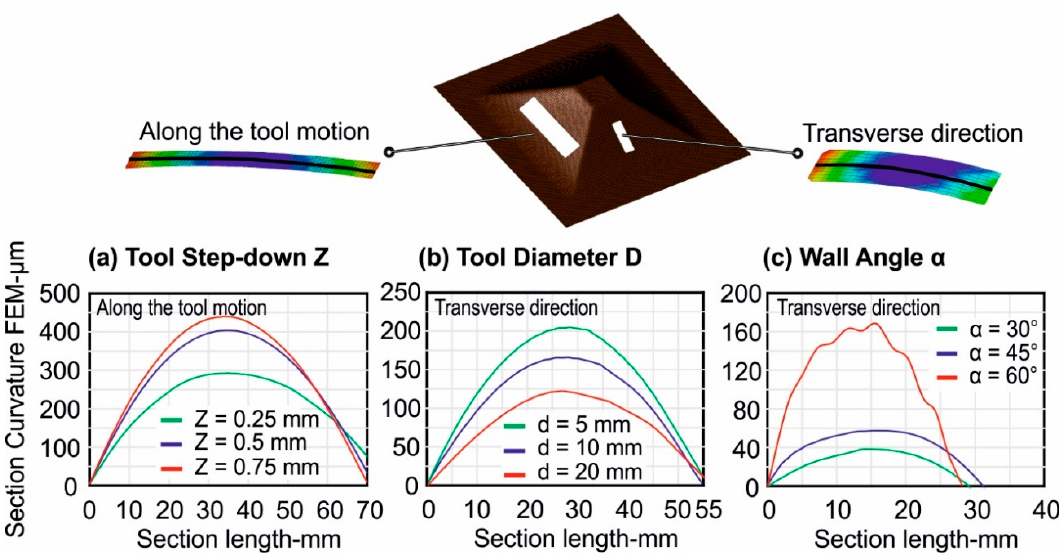
Figure 19. Curvature of the strip only due to the residual stresses upon trimming from numerical simulations for ( a ) three tool step-down values along the tool motion, ( b ) three tool diameters in the transverse direction, and ( c ) three wall angles along the transverse direction.